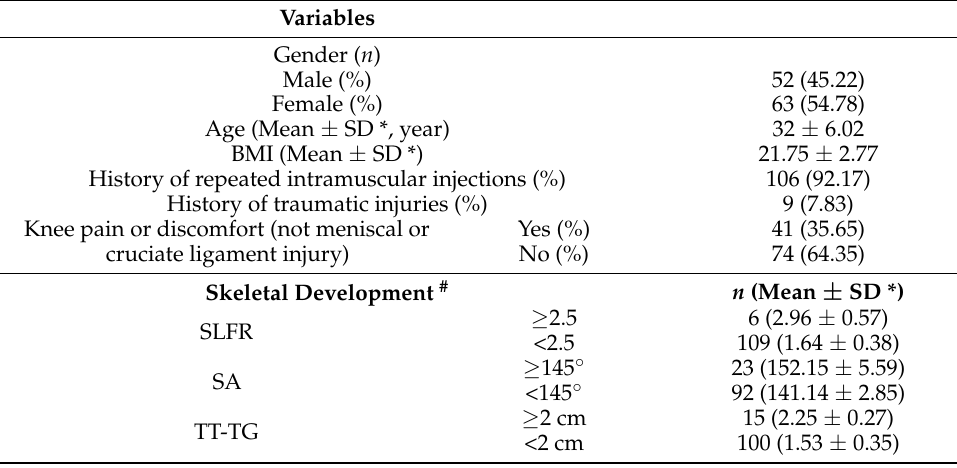
Table 1. Patient demographics ( n =